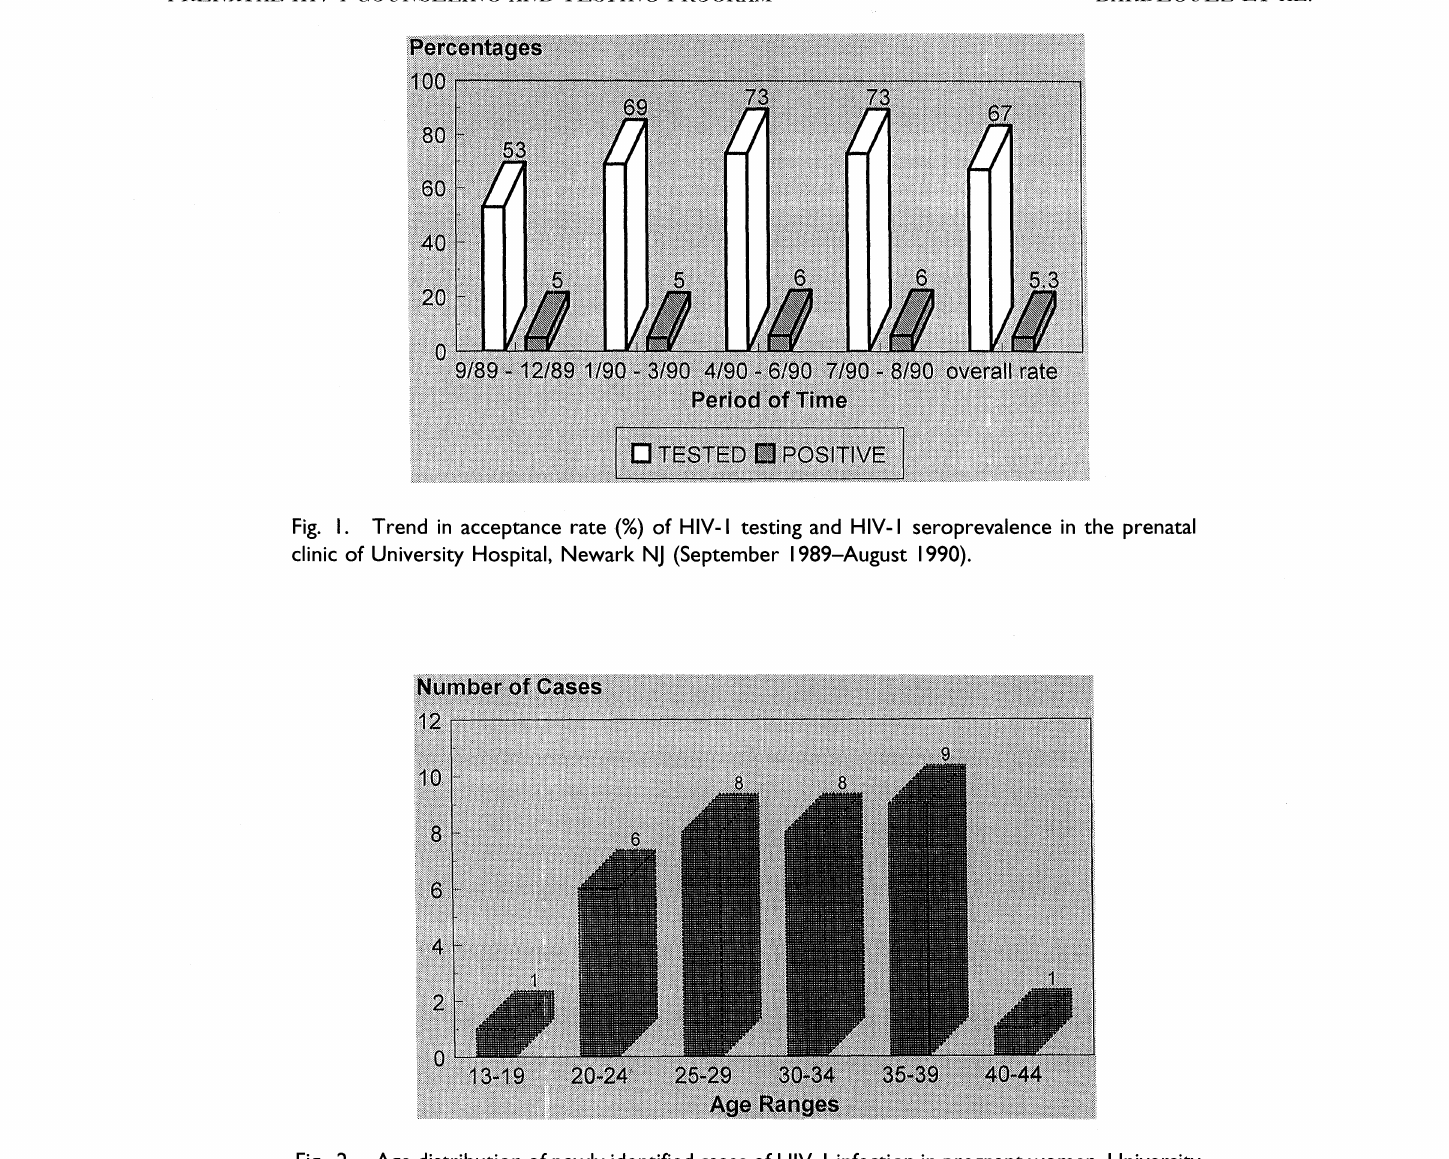
Fig. 2. Age distribution of newly identified cases of HIV-I infection in pregnant women, University Hospital, Newark, NJ (September 1989-August